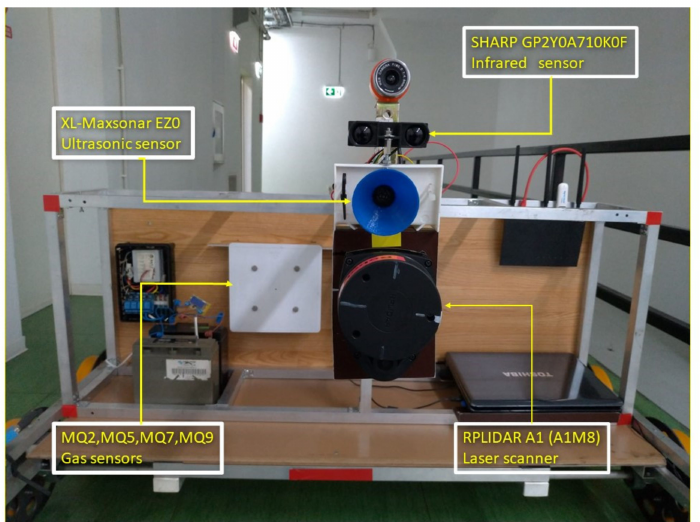
Figure 4. Frontal view of the equipment.